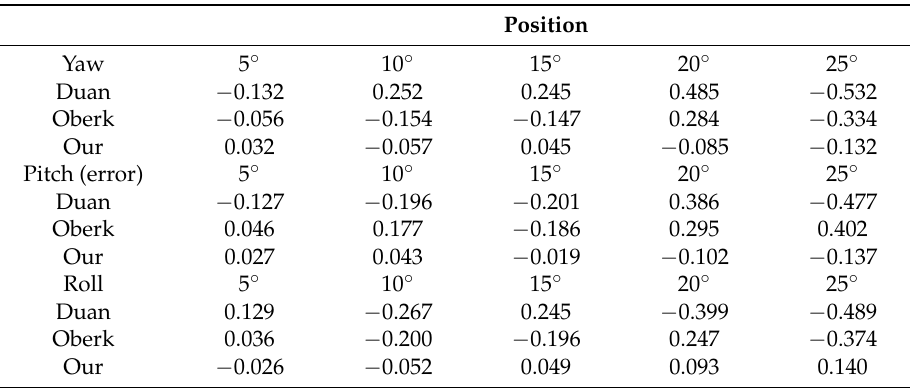
Figure 10. The image of the rotation stage with feature points. Table 3. The measurement errors of the rotation stage with feature